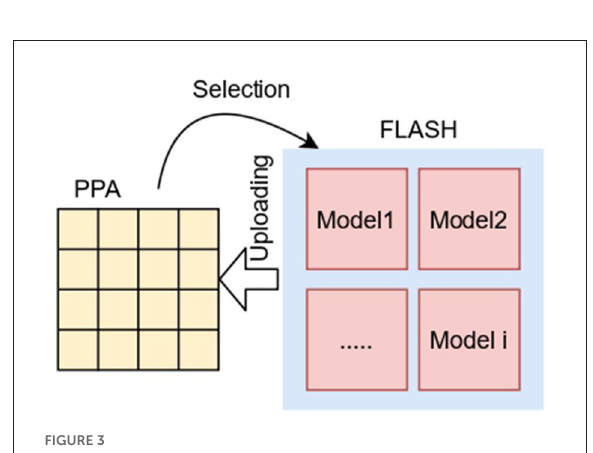
FIGURE3 Neural network dynamic model swapping for the